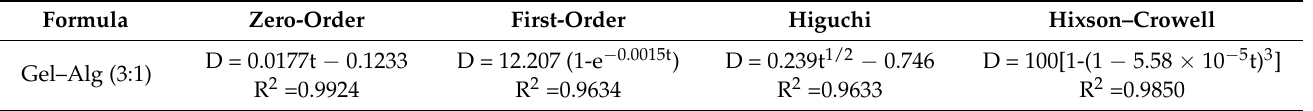
Table 2. The simulation results of dynamic model of Gel–Alg